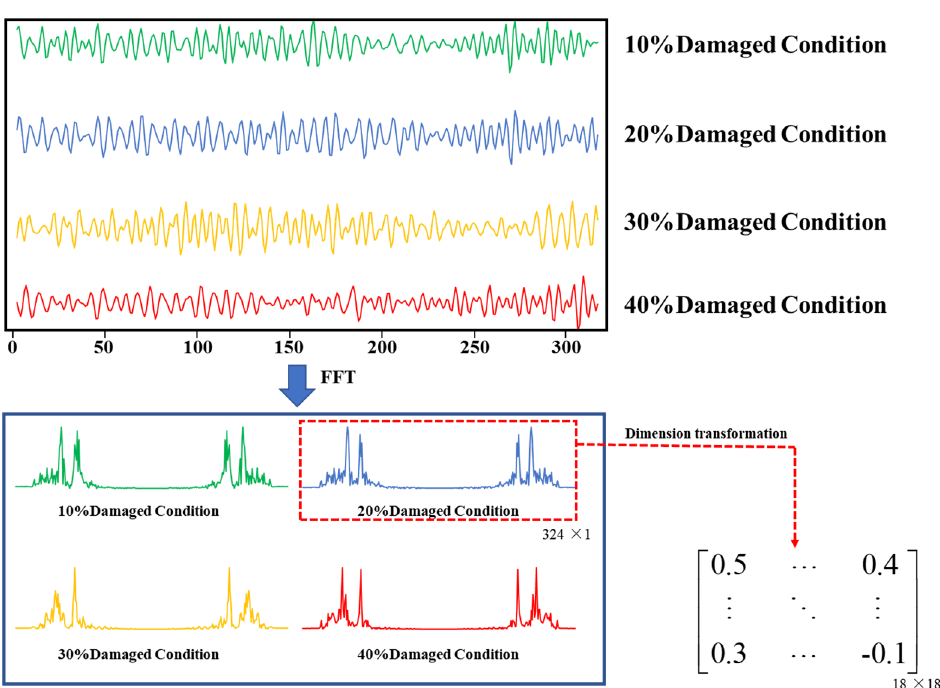
Figure 6. Vibration signal decomposition via FFT method.